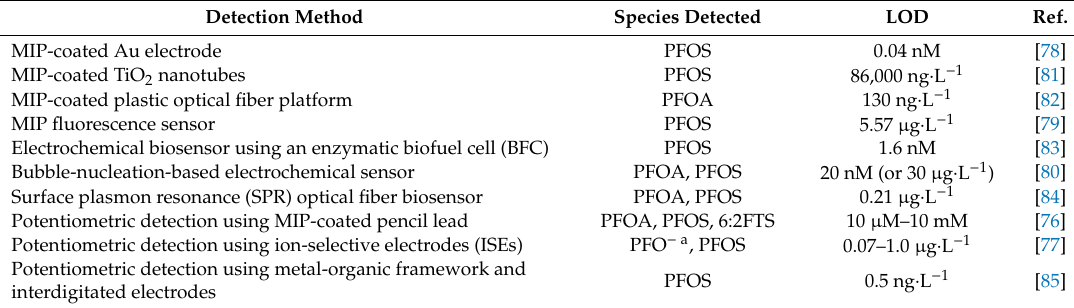
Table 2. Methods of sensor detection of various PFAS species and their respective detection